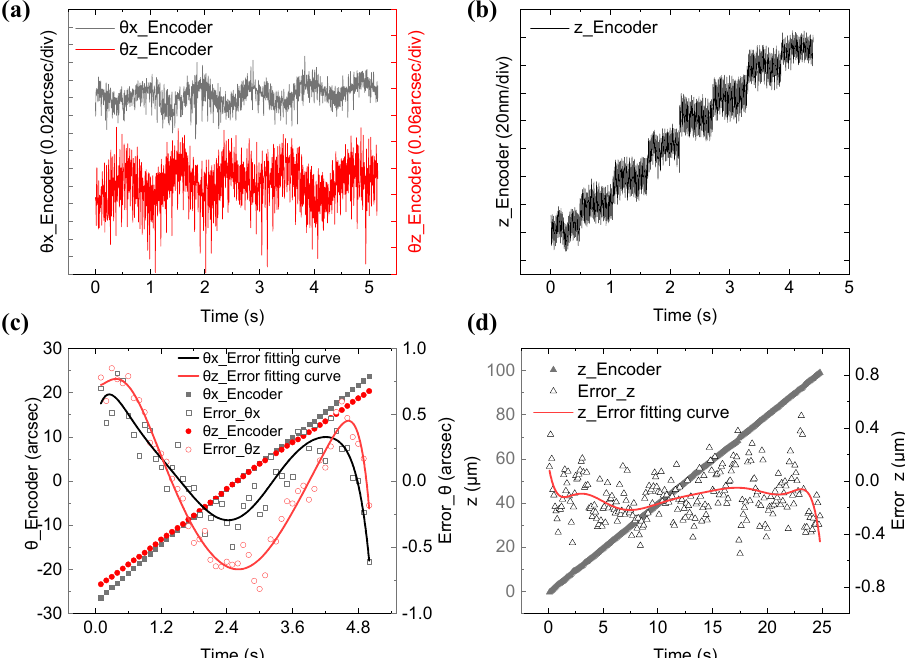
Figure 5. ( a ) Angle resolution of the encoder; ( b ) displacement resolution of the encoder; ( c ) angle error between the encoder value and the true value in a single degree; ( d ) the displacement error between the encoder value and the true value in a single degree.